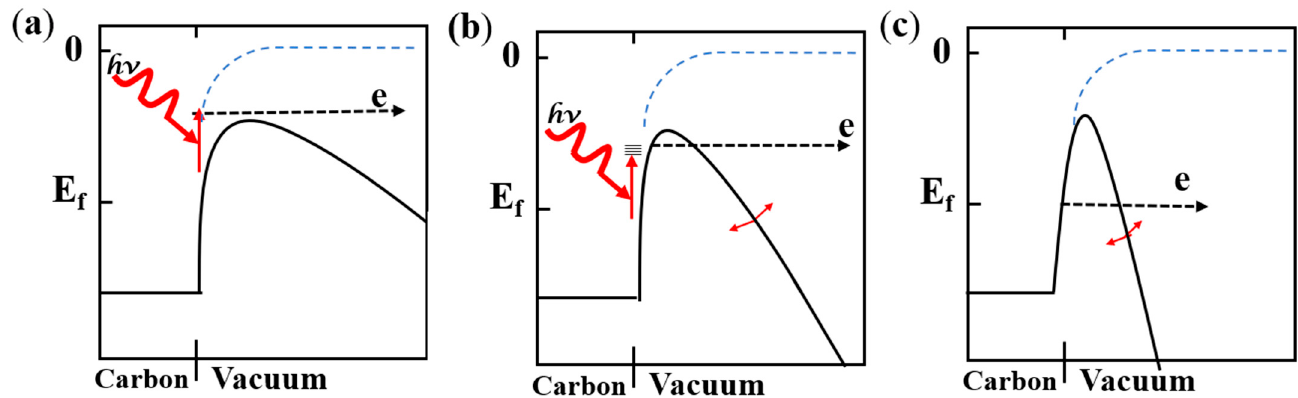
Figure 4. Energy diagrams for ( a ) photo-electron emission, ( b ) optically induced field emission, and ( c ) field emission.